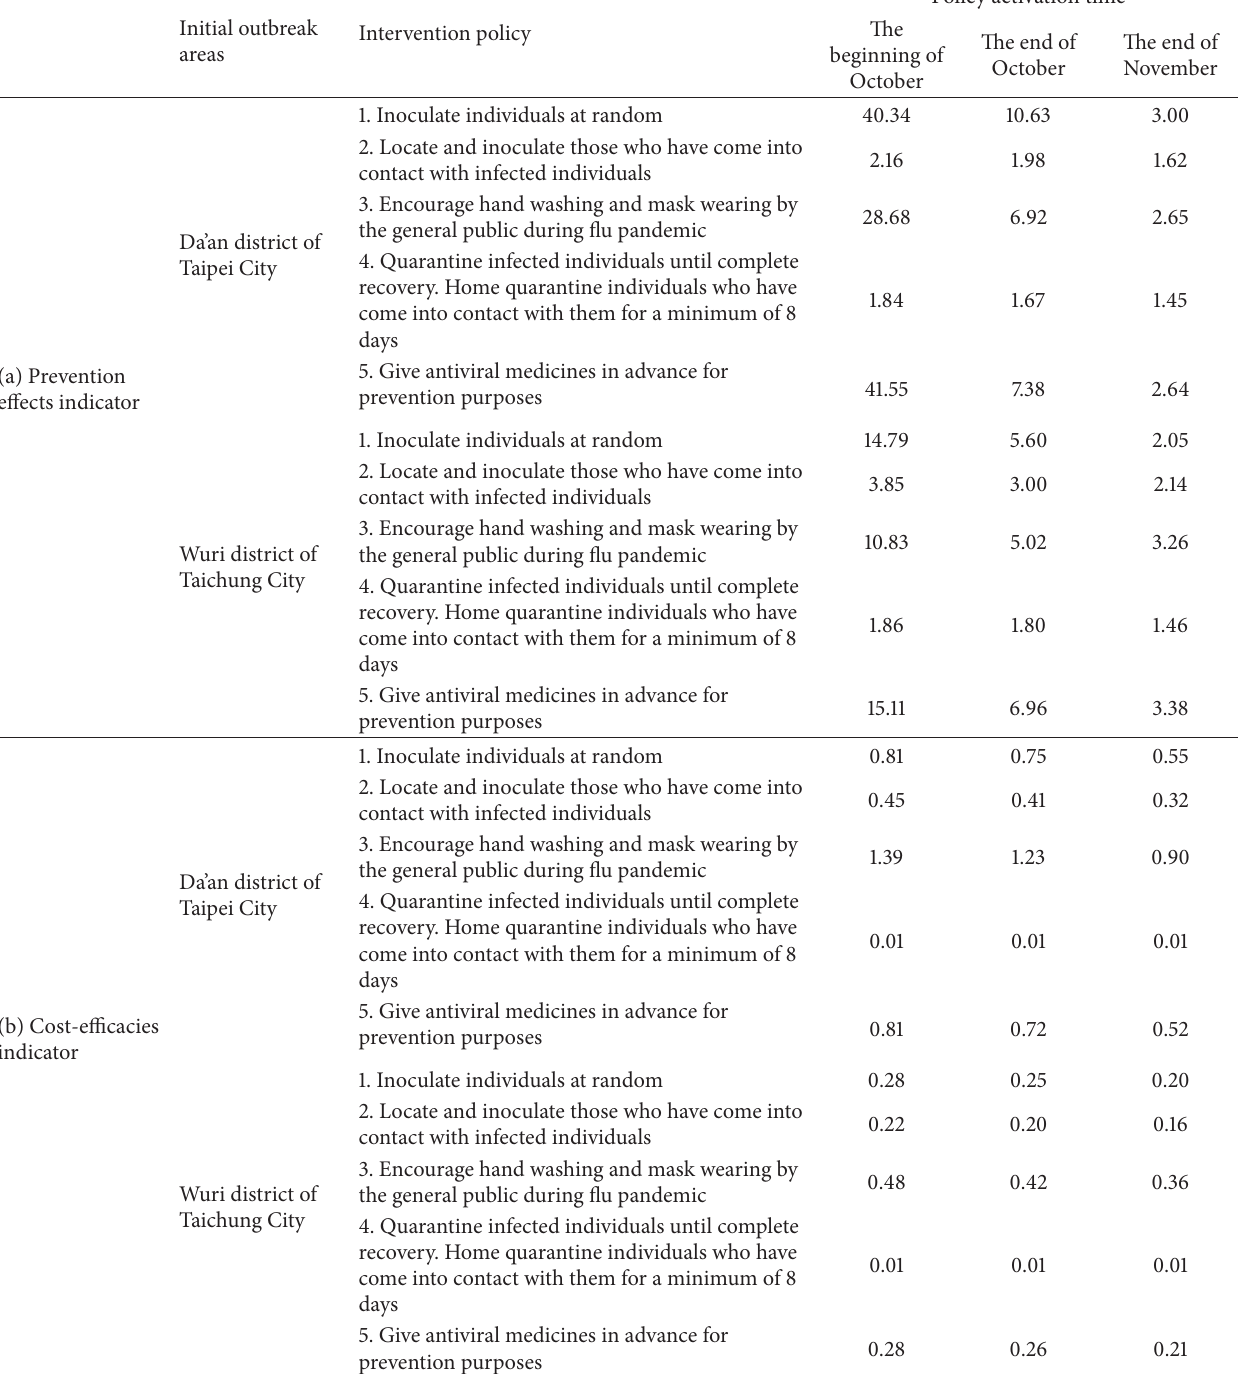
Table 4: Comparisons of (a) prevention effects and (b) cost-efficacies among five intervention policies.